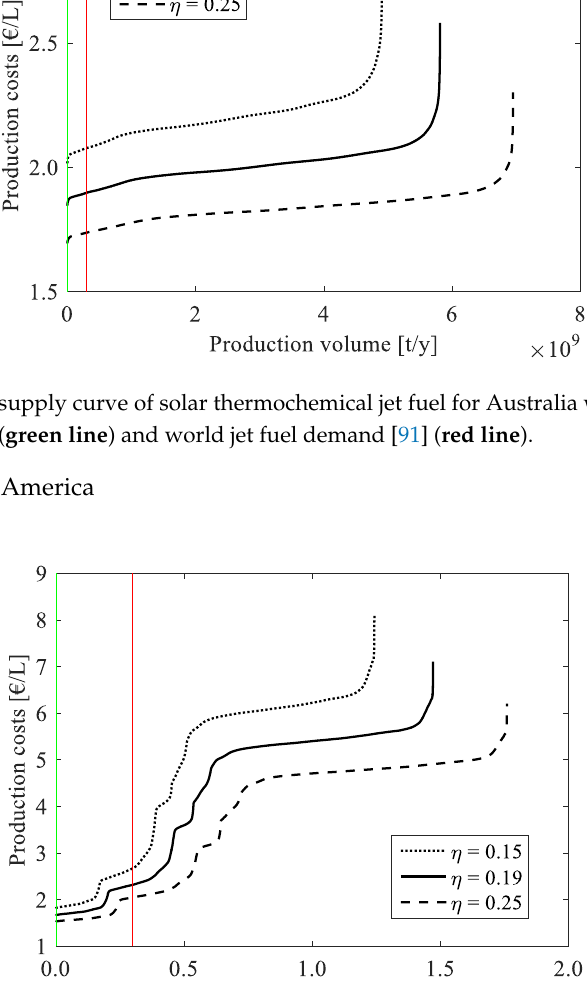
Figure A2. The cost-supply curve of solar thermochemical jet fuel for the USA with current US jet fuel demand [94] ( green line ) and world jet fuel demand [92] ( red line ).